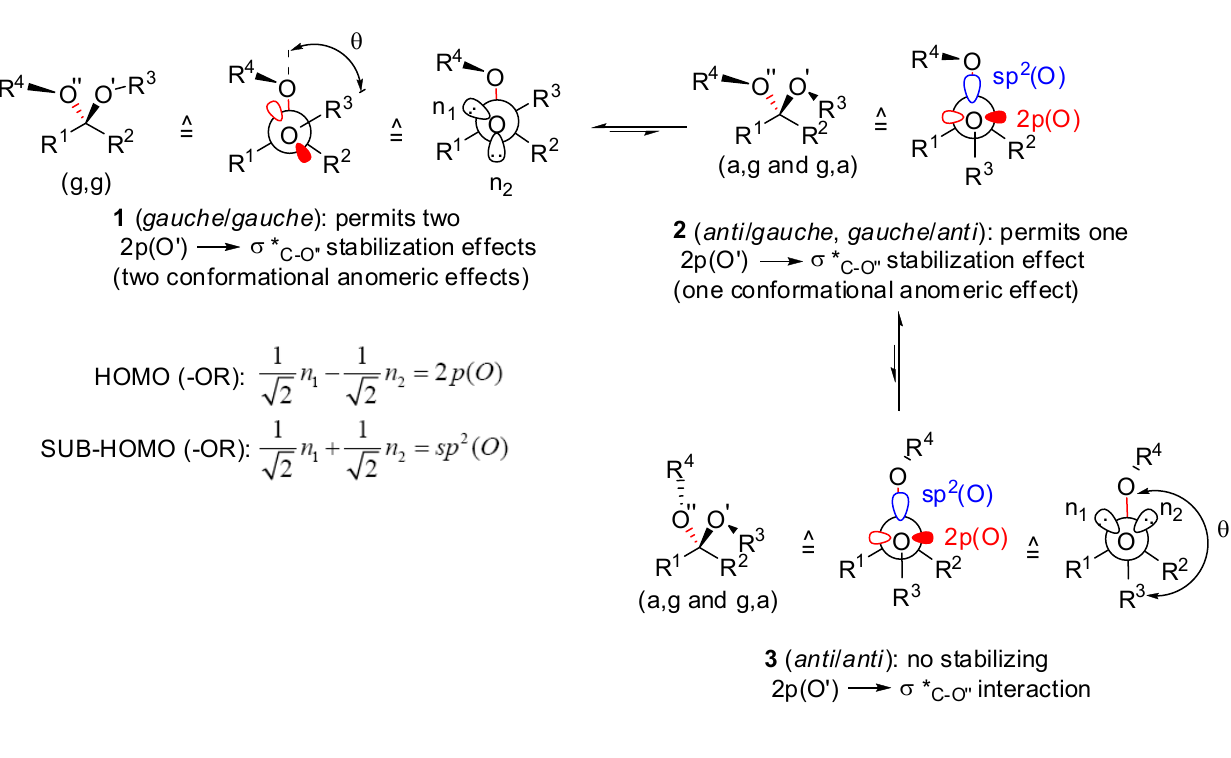
Figure 2. Possible conformations of hemiacetals and